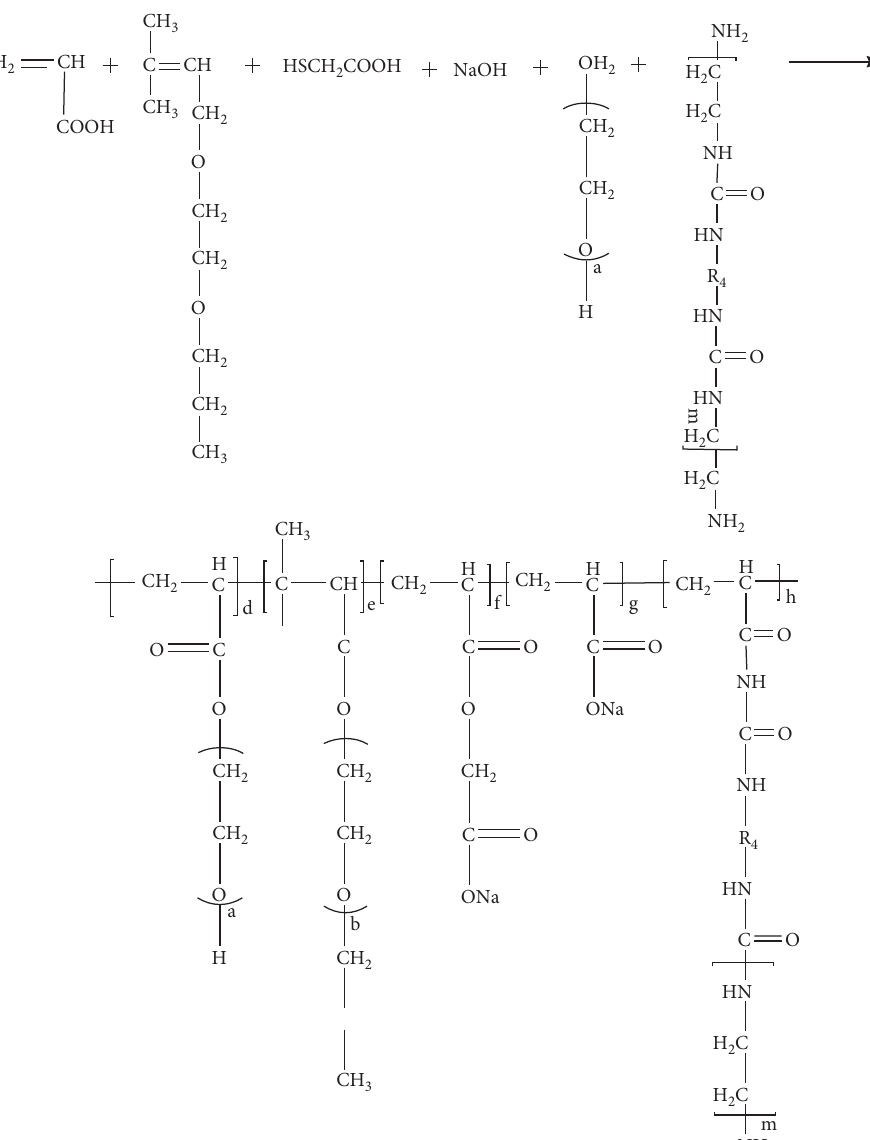
Figure 3: Chemical structure of synthesized